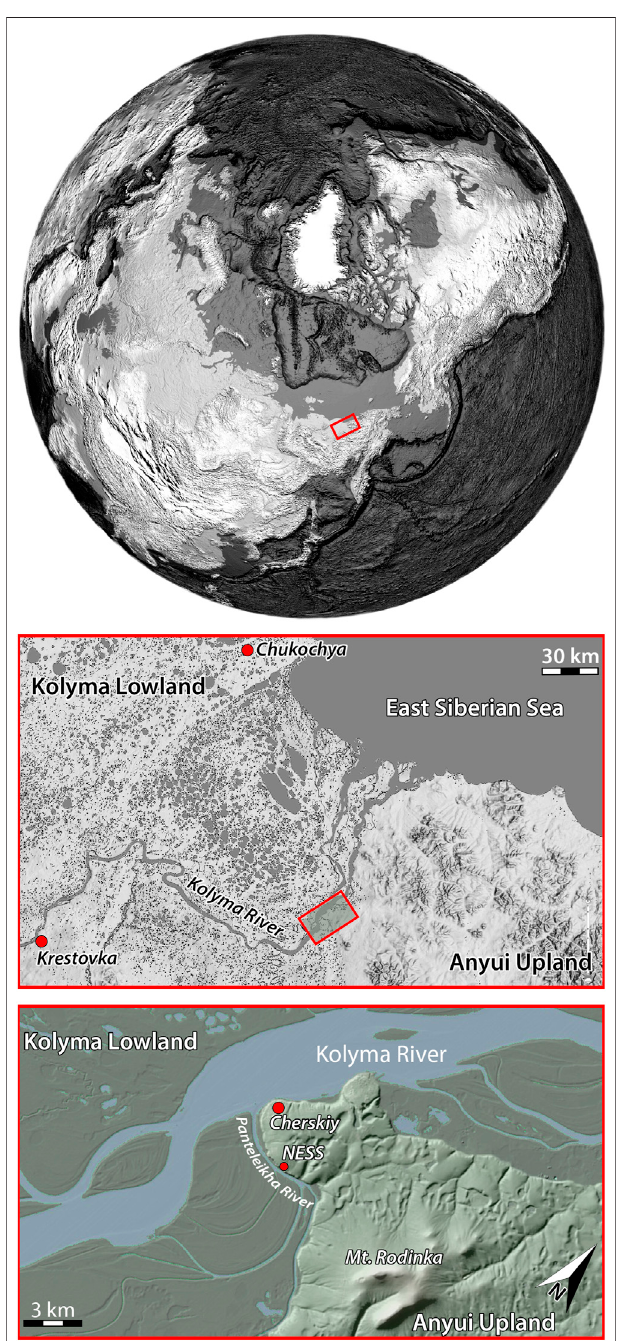
FIGURE 1 | Location in the western part of Beringia (upper part), topography and regional context of the study site at the junction of the Northeast Siberian coastal lowlands and the Far Eastern Anyui uplands (central part) as well as location of the Chukochya and Krestovka sites. The study site is situated in close proximity to the North East Science Station (NESS) Cherskiy at the westernmost edge of the Anyui Upland (lower part). Upper part adapted from the NGDC, NOAA Satellite and Information Service, available at http://www.ngdc.noaa.gov/mgg/global/; central and lower part Digital Elevation Model adapted from the Arctic DEM Explorer available at https://livingatlas2.arcgis.com/